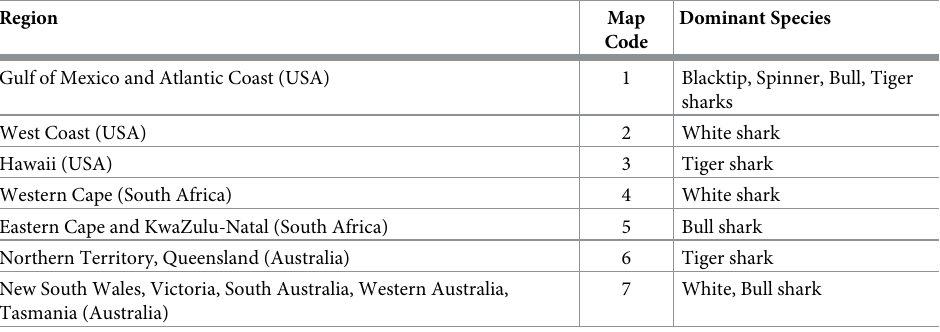
Table 2. Descriptions of regions used (with corresponding country in parenthesis), the corresponding Map code in Fig 1, and the dominant attributed shark species for that region. Region Map